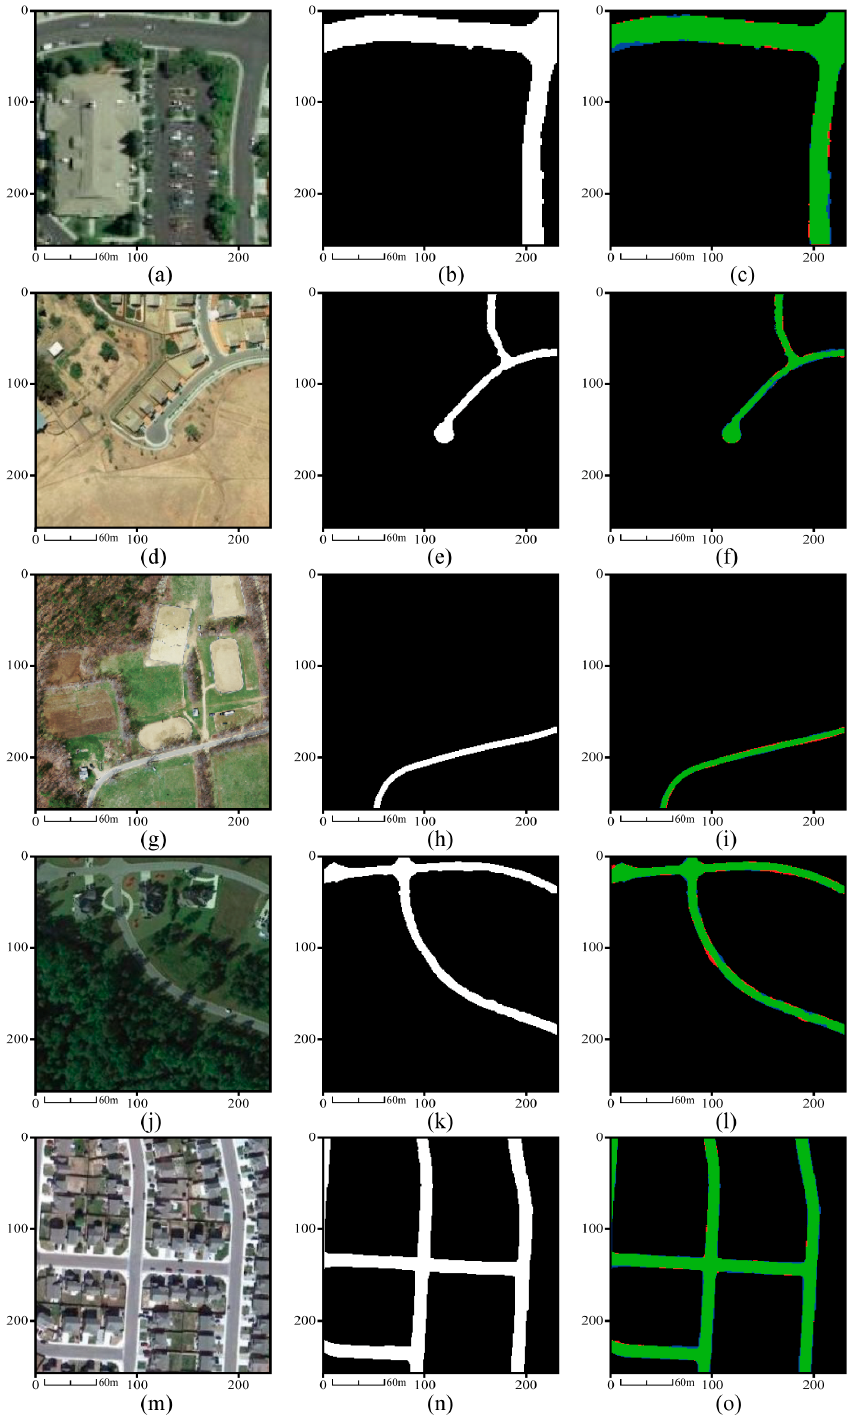
Figure 7. Results of roads extraction using the proposed GL-Dense-U-Net model. The original images ( a , d , g , j , m ), while the corresponding ground truths ( b , e , h , k , n ) and predictions ( c , f , i , l , o ) are also given. Green, red and blue represents the TP, FP and FN, respectively.